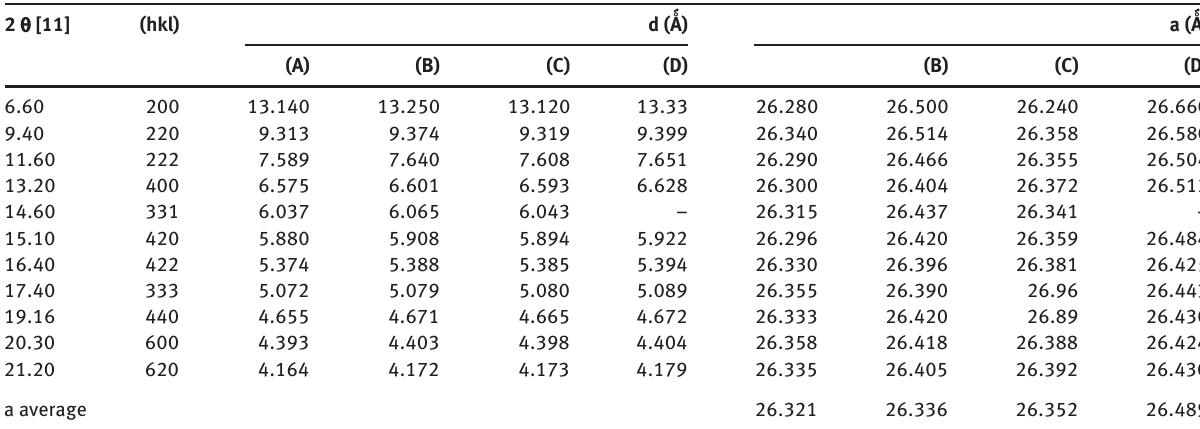
Figure 9: X-ray diffraction patterns of hydrated Cu-BTC, formed from Cu and benzene-1,3,5-tricarboxylic acid, [dry at 40 ° C (A), immer- sion during 0 min (B), 20 min (C), 30 min (D), 4 h (E), 13 h (F), 18 h (G) and 24 h (H)] (2-Cu-BTC 3D; 3-C 6-C H CuO ·2H O). 4 4 4 2 Table 6: 2 θ value, (hkl), distance between crystal plane d and lattice parameter a of Cu-BTC 3D, formed from Cu and